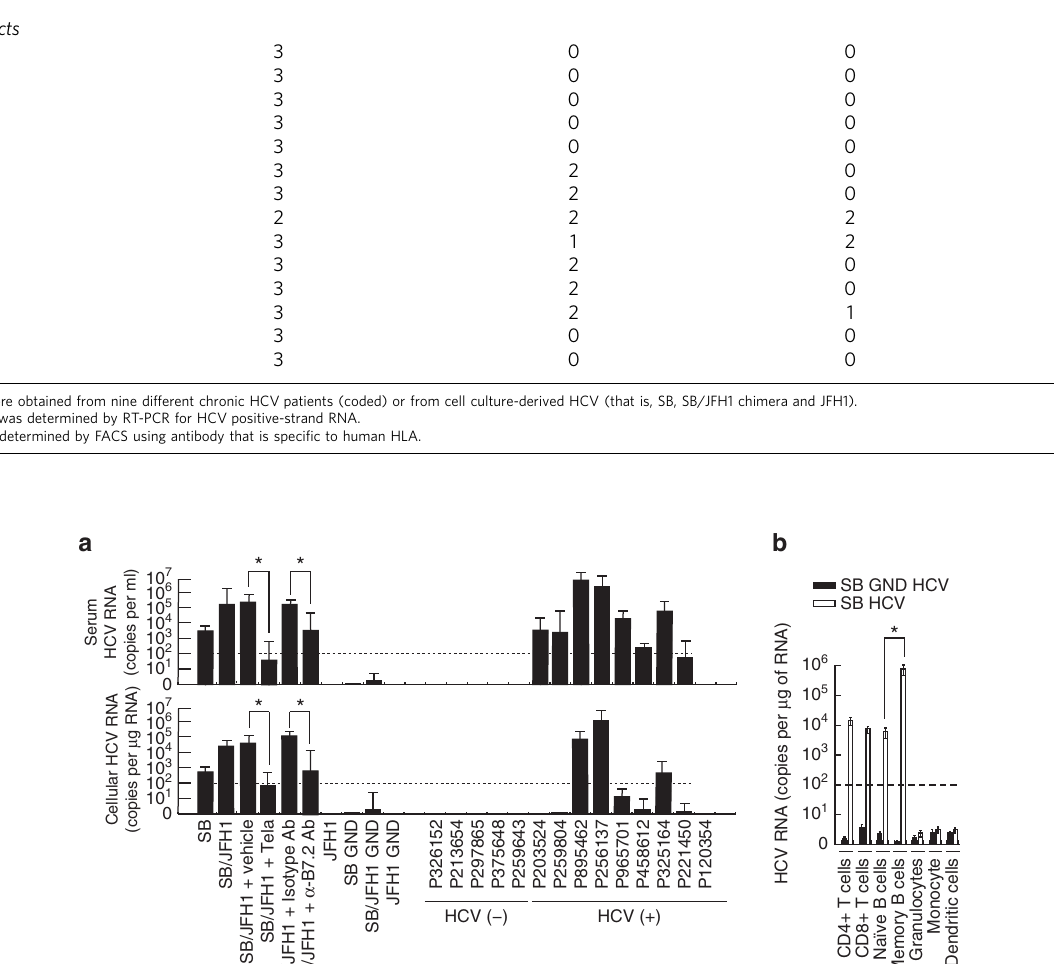
NATURE COMMUNICATIONS|8:13882|DOI: